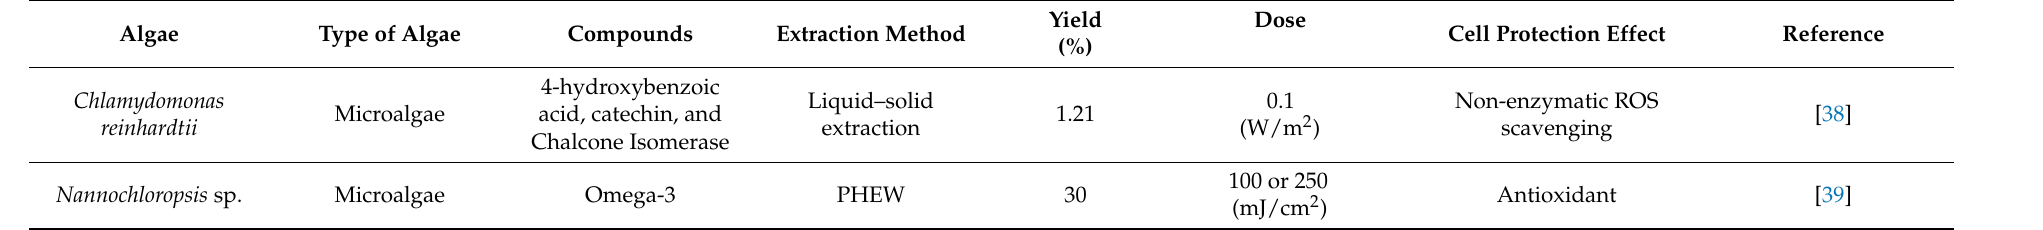
Table 3. Algae compounds obtained by UVC